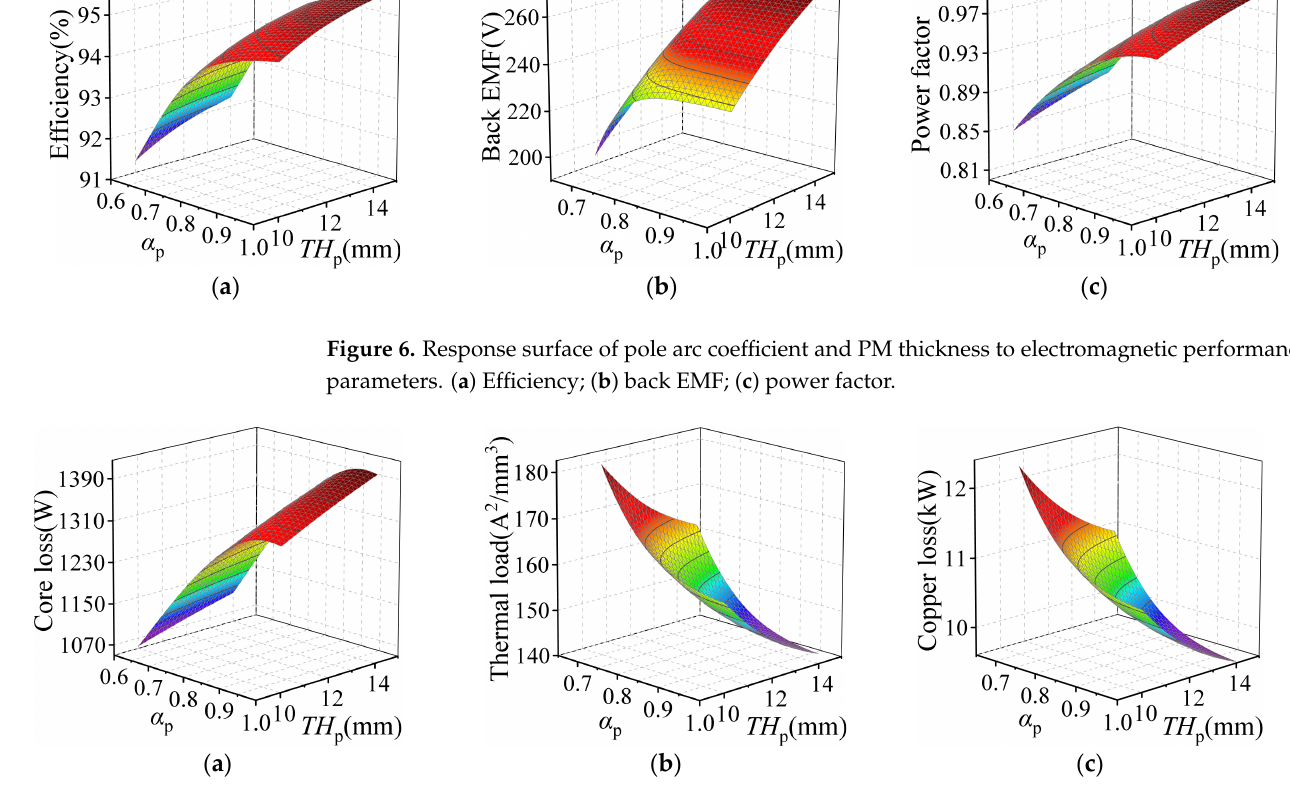
Figure 7. Response surface of pole arc coefficient and PM thickness to electromagnetic performance parameters. ( a ) Core loss; ( b ) thermal load; ( c ) copper loss.